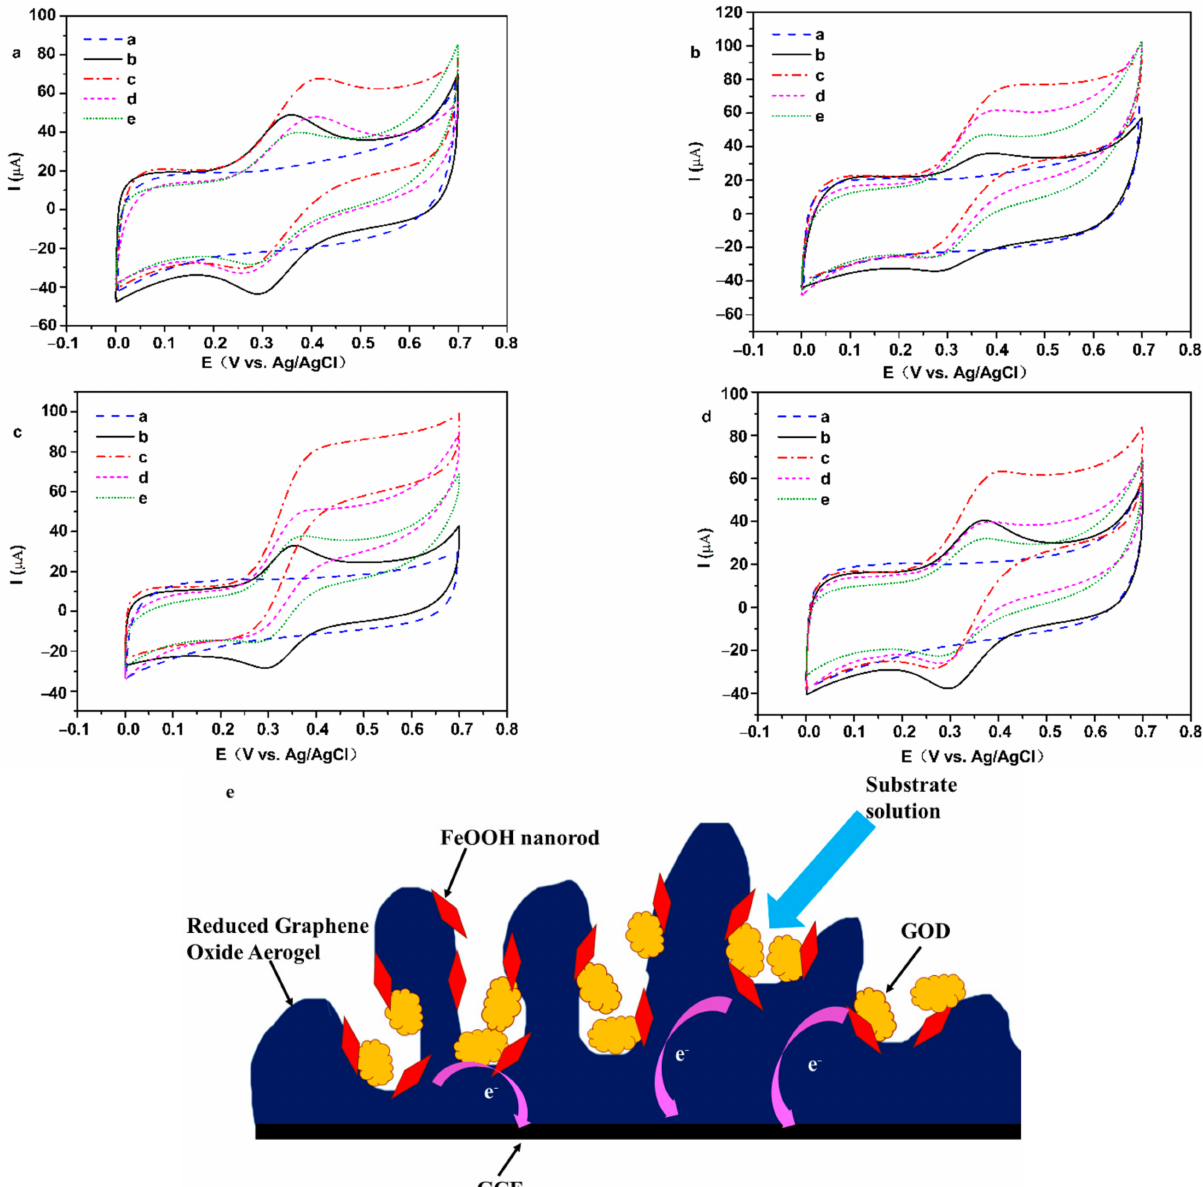
Figure 11. The CV curves of Nafion/GOD/FeOOH-GA 0.125 /GCE ( a ), Nafion/GOD/FeOOH-GA 0.25 / GCE ( b ), Nafion/GOD/FeOOH-GA 1.0 /GCE ( c ) and Nafion/GOD/FeOOH-GP/GCE ( d ) in PBS (pH = 7, curve a), PBS including 1 mM Fc (curve b), PBS including 1 mM Fc + 50 mM glucose (curve c at the first day, curve d after 7 days, curve e after 14 days) at 50 mV s − 1 scan rate. The illustration of Nafion/FeOOH-GA/GCE for electrocatalysis ( e